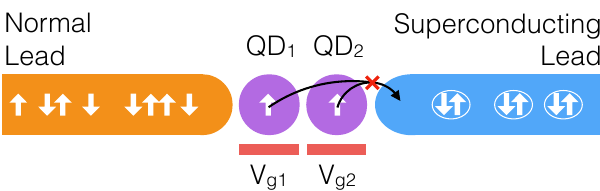
Figure 1: Device schematic: Two quantum dots (labeled QD and QD ) are tunnel 1 2 coupled to each other and to the two leads. The left, normal metal lead supports only single electron tunneling. The right, superconducting lead supports only Cooper pair tunneling. The chemical potentials on the quantum dots are tuned using two gates (labeled V and V ). Quantum dots are shown in the T + ( 1,1 ) configuration, but g 1 g 2 ( 1,1 ) and T ( 1,1 ) Andreev blockade also occurs for T − 0